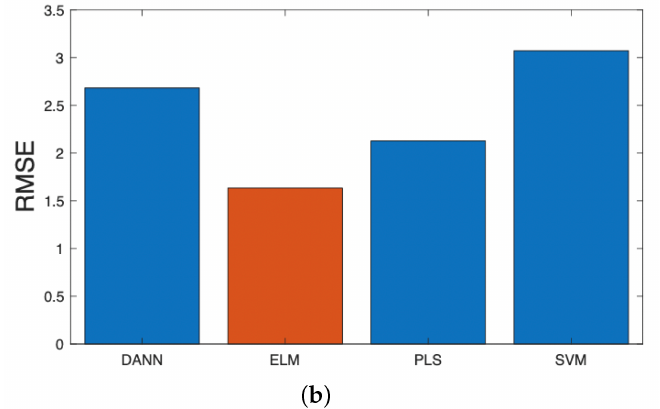
Figure 15. 3-dimensional ( a ) and 2-dimensional ( b ) space of the pressure